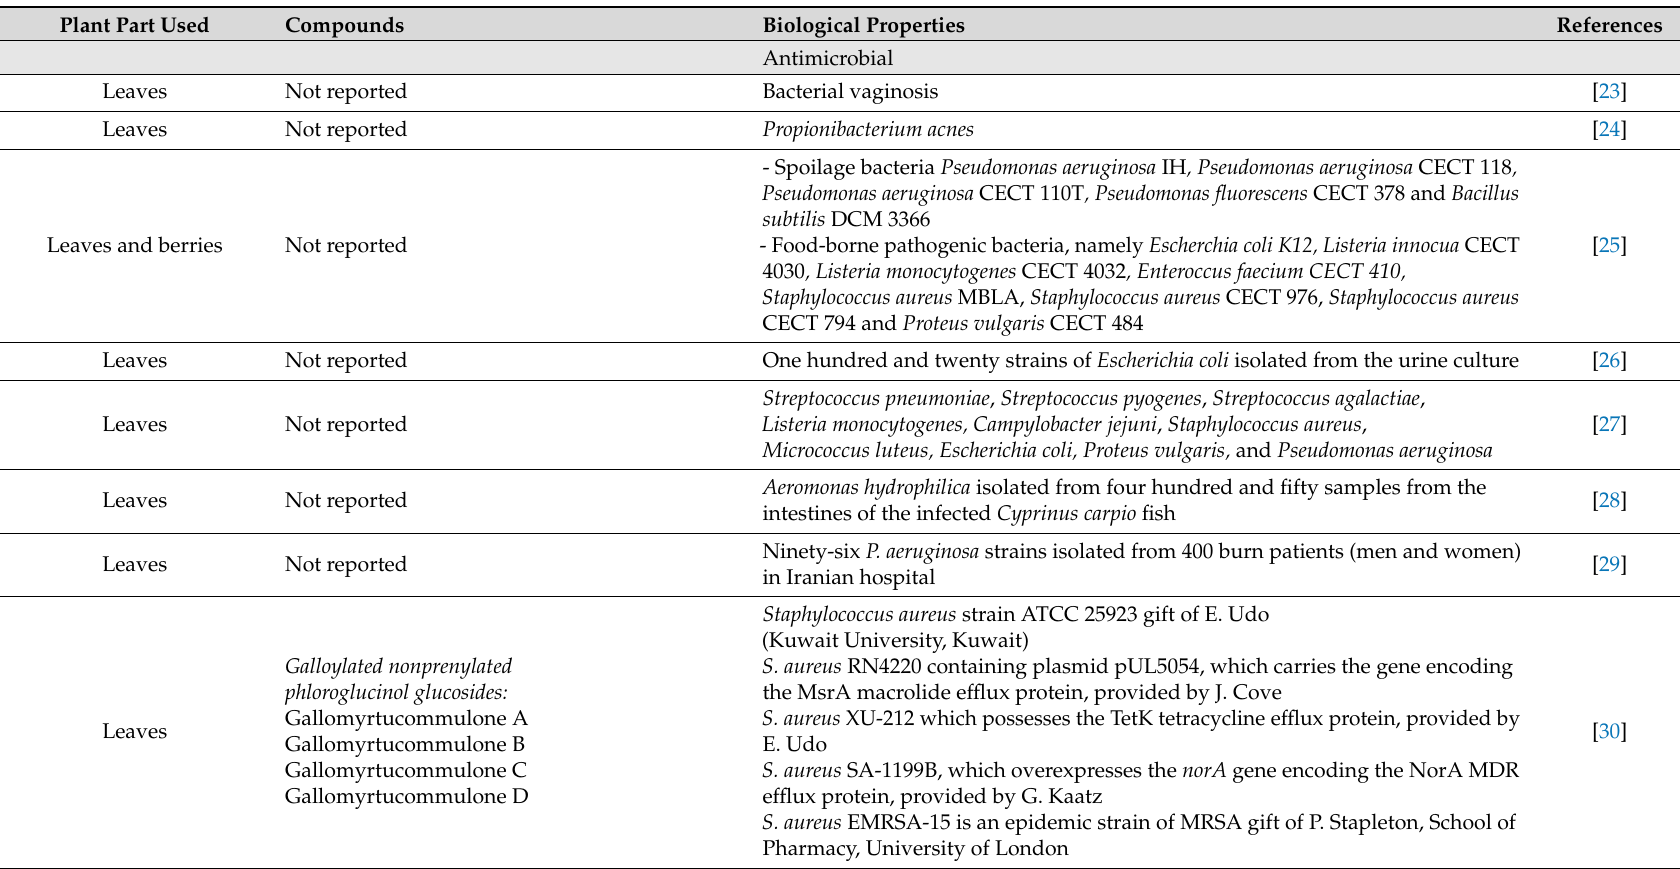
Table 1. Biological properties attributed to Myrtus communis (antioxidant and anti-inflammatory activities are not